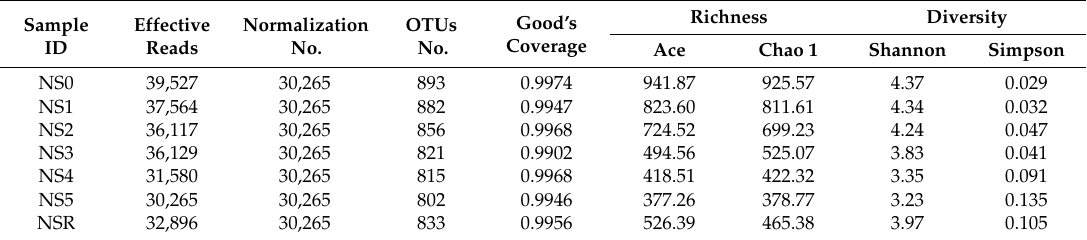
Table 2. Alpha diversity estimators for the abundance and diversity of microbial communities of a nitrification sludge system at different Cr(VI) concentrations.